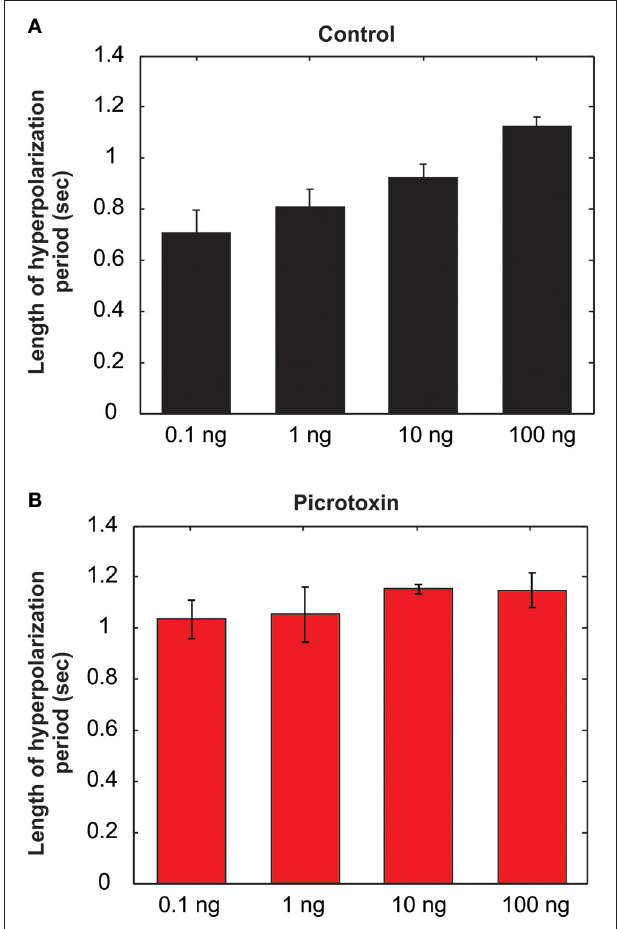
FIGURE 7 | The length of the afterhyperpolarization (AHP) period is positively related to the odor concentrations under saline control (A), but the linear relationship is lost after picrotoxin treatment (B) ( N = 8